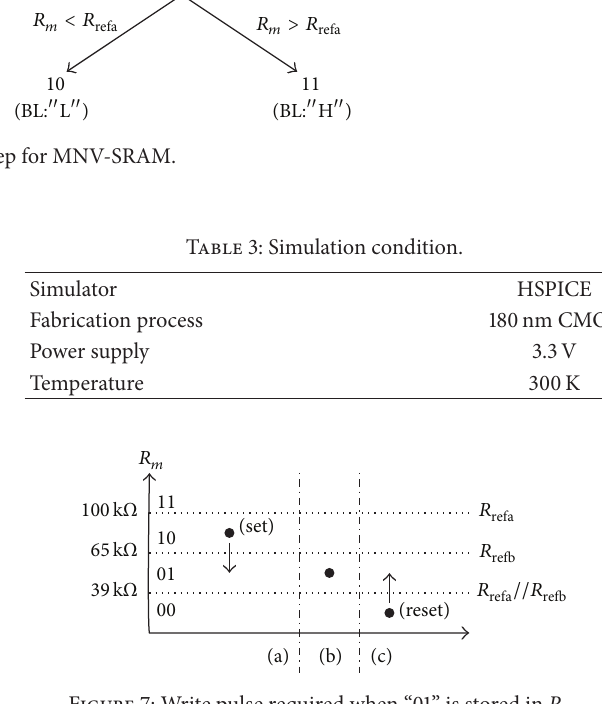
Figure 7: Write pulse required when “01” is stored in 𝑅 𝑚